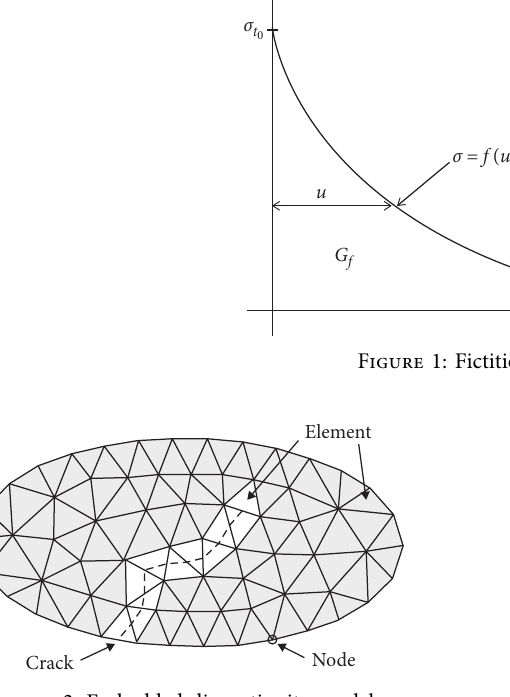
Figure 2: Embedded discontinuity